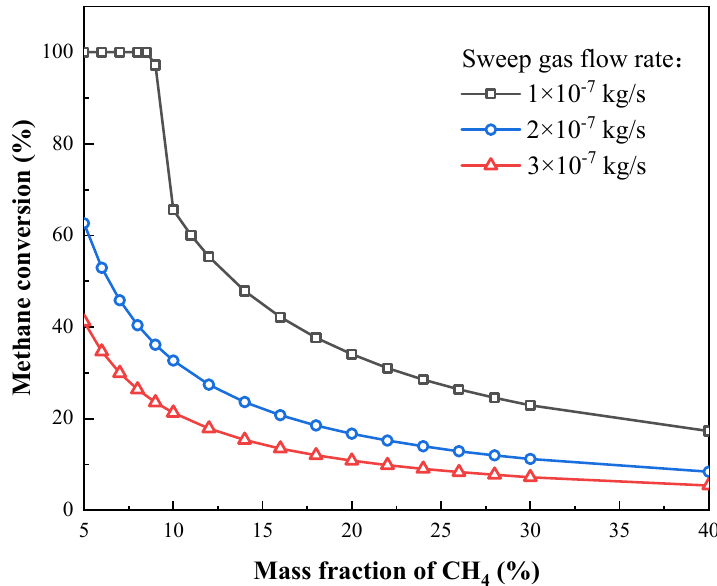
Figure 11. Methane conversion at different sweep gas flow rate and methane content.